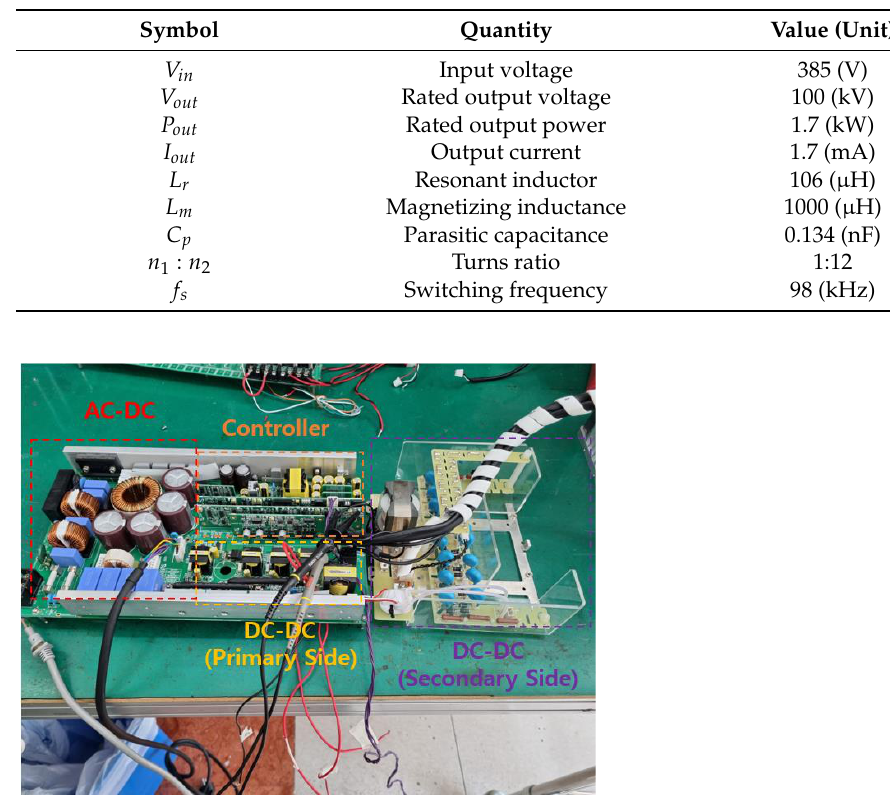
Figure 8. Experimental setup for the proposed parallel resonant converter system.